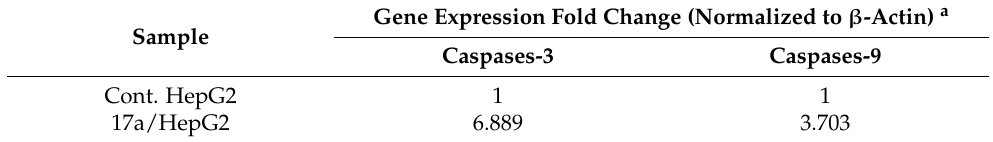
Table 5. The gene expression fold change of caspases-3 and -9 in the HepG2 cells treated with 17a .